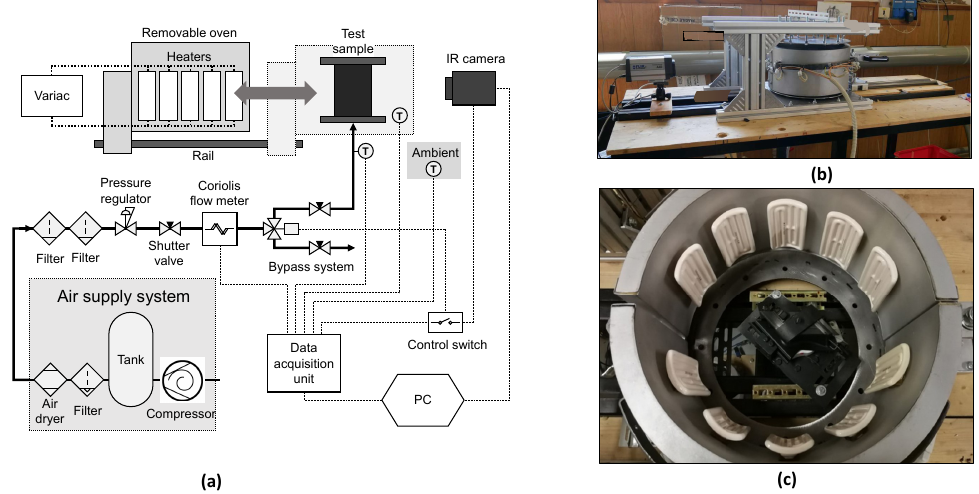
Figure 1. Schematic of the Test rig. ( a ) Test rig overall assembly. ( b ) Geometry inside the oven ( c